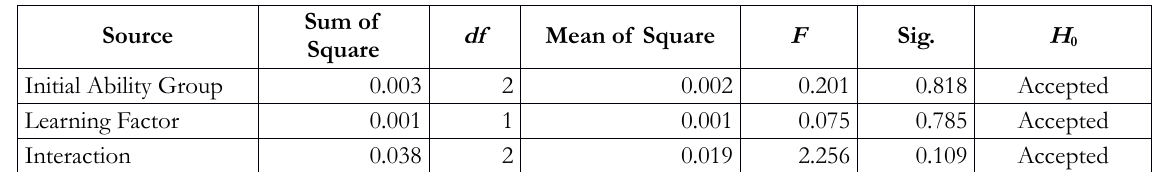
Table 6. Two Ways ANOVA Result of the Enhancement of Students’ Mathematical Understanding